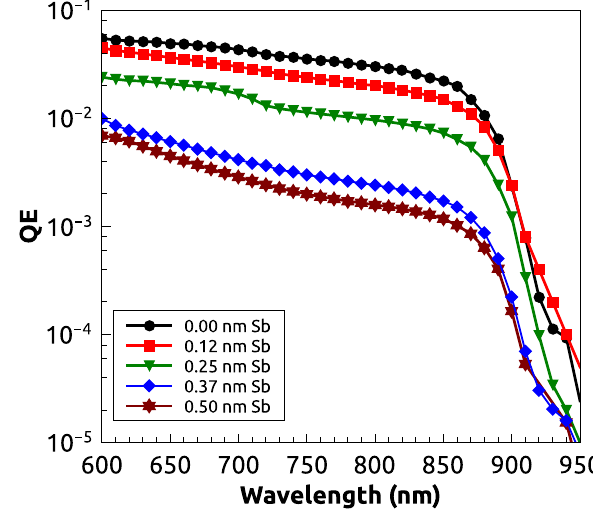
FIG. 4. Spectral response of the 5 samples as measured after growth. While NEA is present in all the samples, demonstrated by sensitivities extending well beyond the 875 nm (corresponding to the nominal value of the GaAs band gap of 1.42 eV), the overall efficiency decreases as the equivalent thickness of the Sb layer